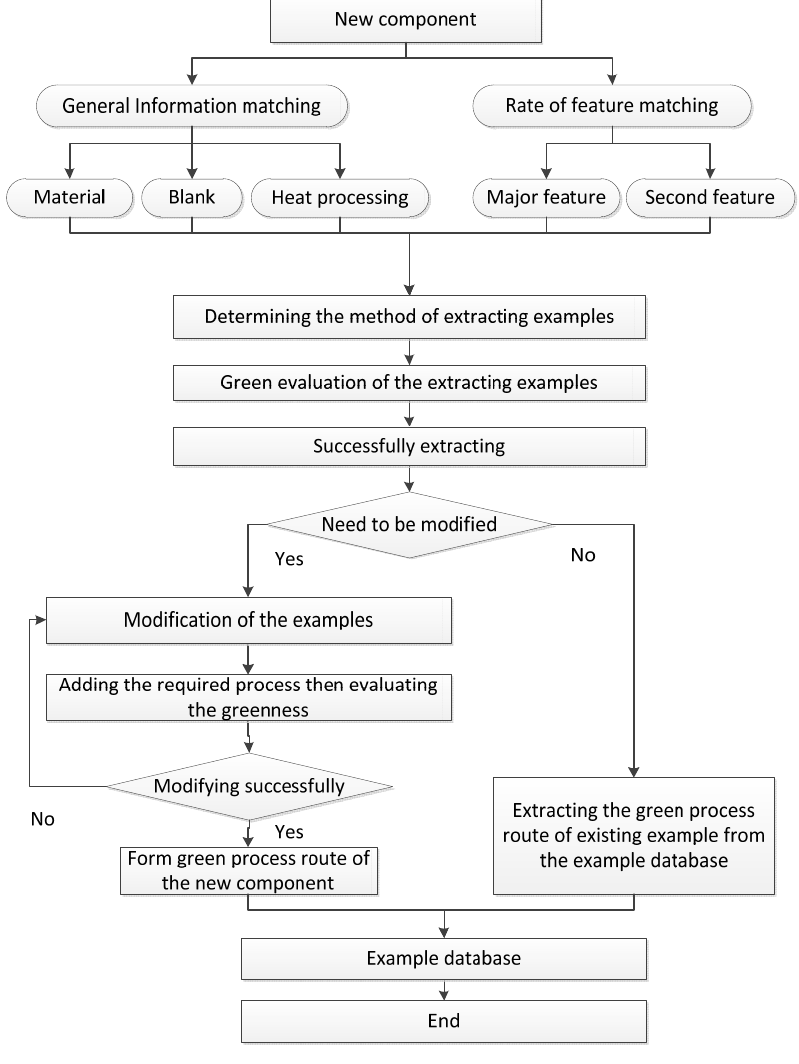
Figure 4. Cased-based optimization flow chart for the process flow of process planning in terms of EBM.